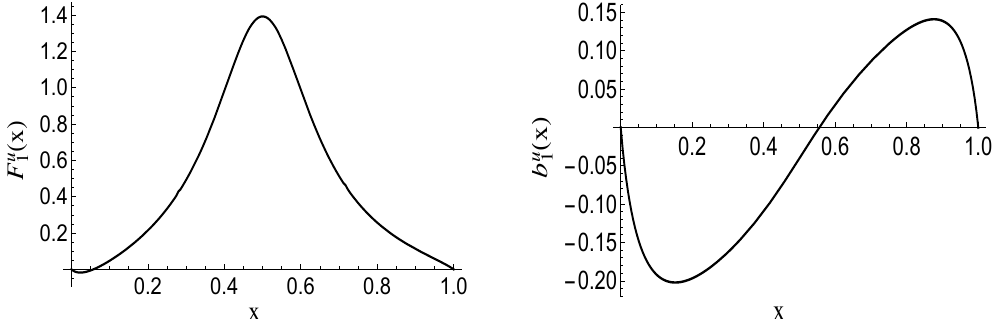
(solid black curve), c (dotted-dashed blue curve) Q ( t ) contributed by the u quark. 1